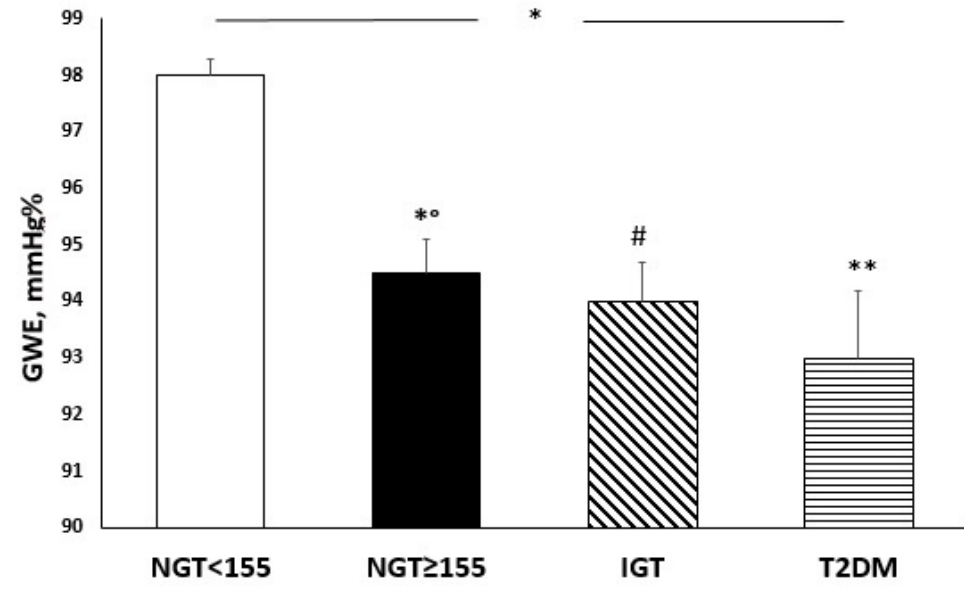
Figure 4. Global myocardial work values (mmHg%) according to different groups of glucose tolerance. * p < 0.0001 (ANOVA test); ** p < 0.0001 vs. NGT < 155, *° p = 0.016 vs. NGT < 155; # p = 0.001 vs. NGT < 155 (Bonferroni post hoc test).